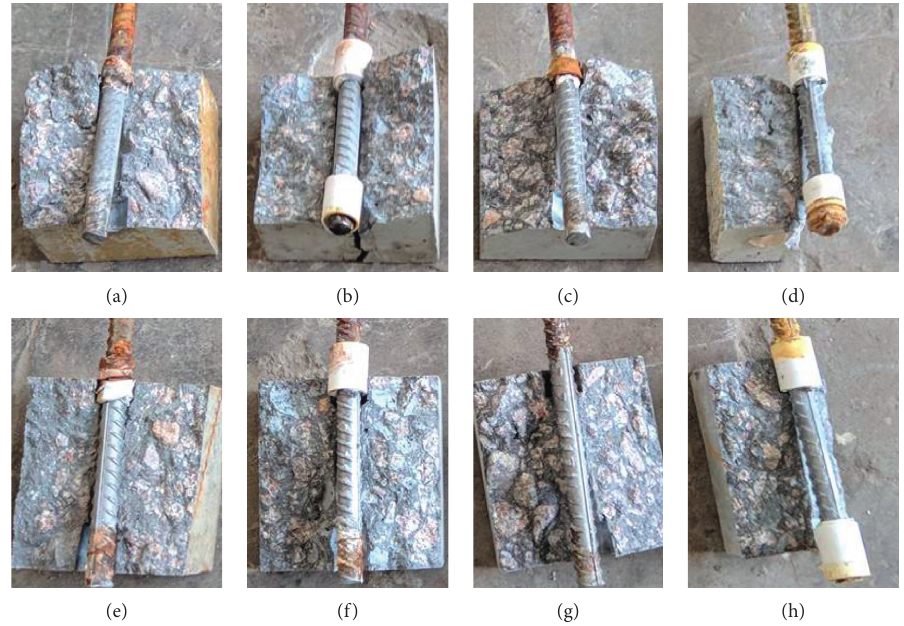
Figure 7: Bond strength specimens after 300 days of corrosion: (a) immersion 0%, (b) immersion 0.27%, (c) immersion 0.8%, (d) immersion 3%, (e) dry-wet 0%, (f) dry-wet 0.27%, (g) dry-wet 0.8%, and (h) dry-wet